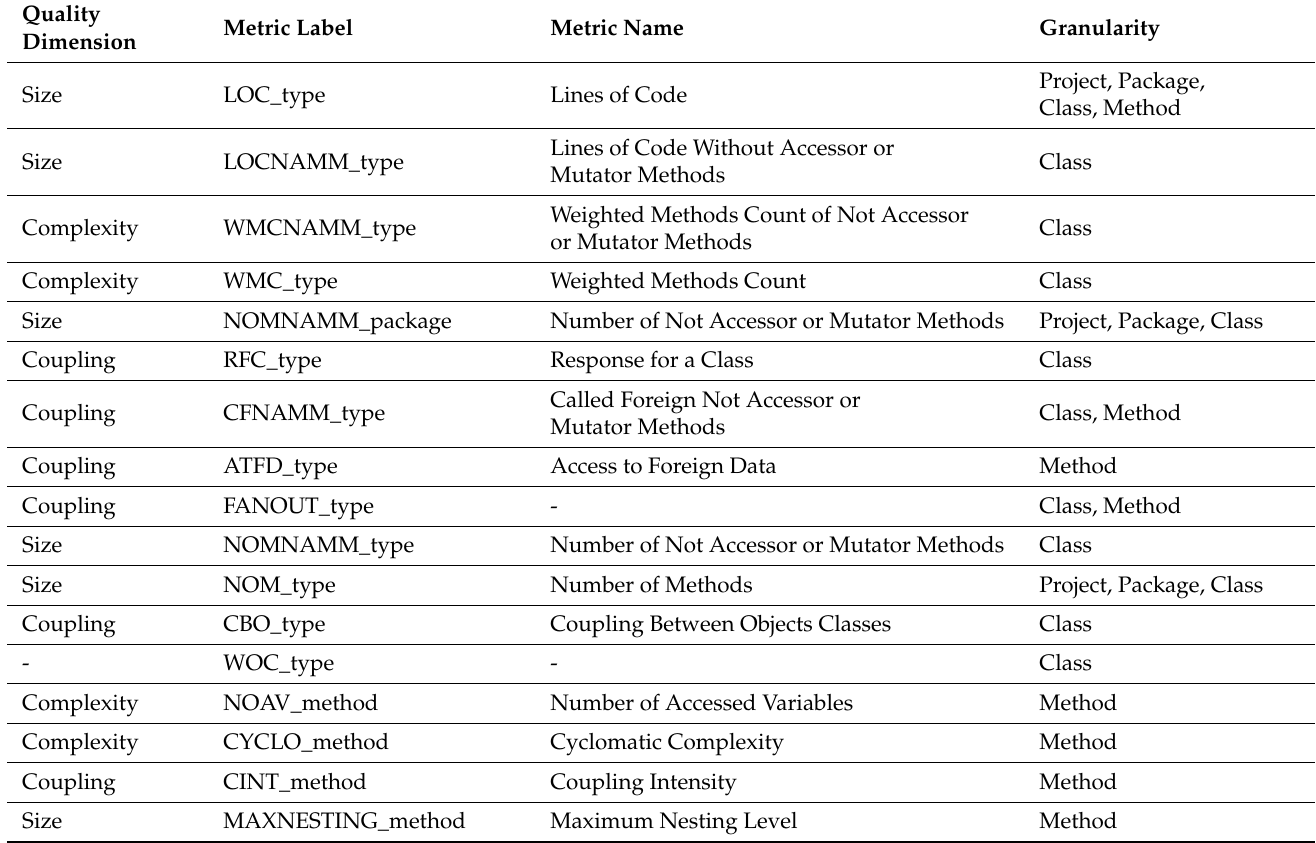
Table A2. Description of all selected metrics